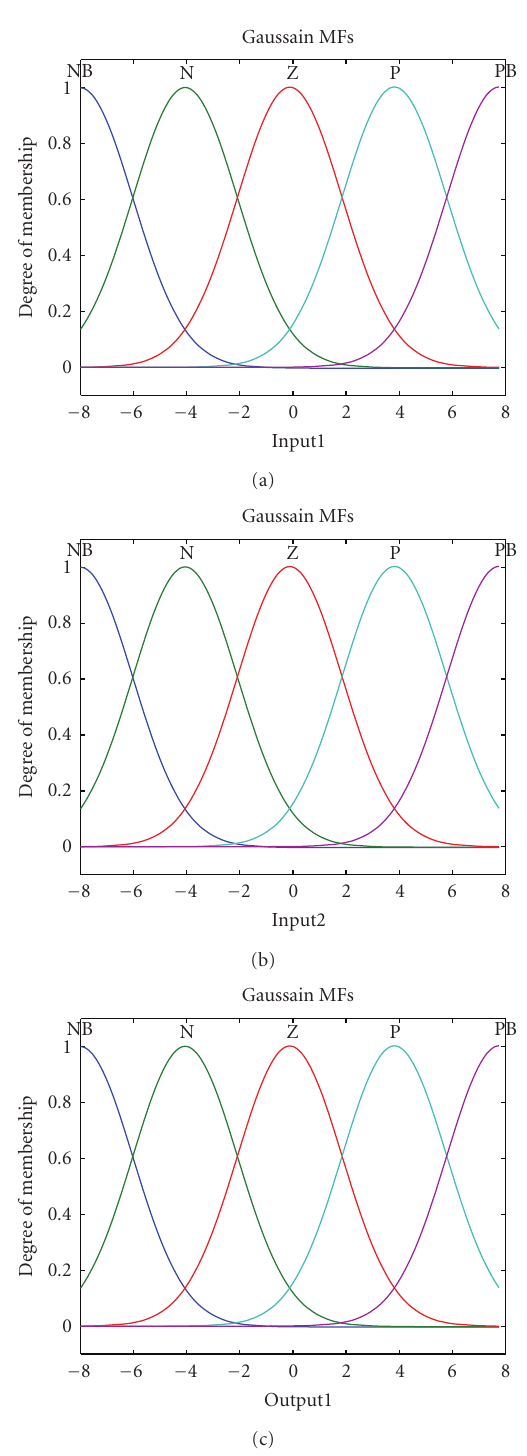
Figure 5: The membership functions of the fuzzy Kalman filter for Gaussian MFs.